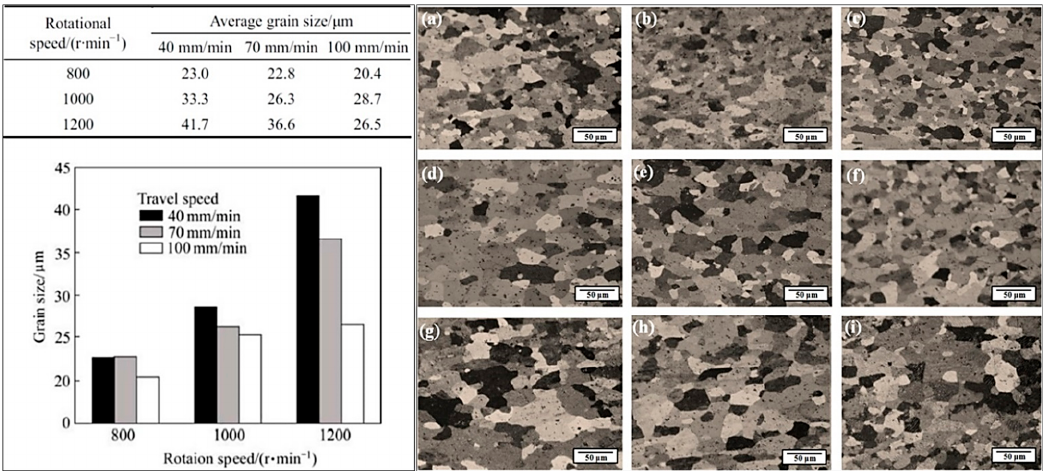
Figure 4. Optical microscope images and average grain size values of HAZ in FSW joint of AA3003- H18 at various rotation and travel speeds: ( a ) 800 r/min, 40 mm/min; ( b ) 800 r/min, 70 mm/min; ( c ) 800 r/min, 100 mm/min; ( d ) 1000 r/min, 40 mm/min; ( e ) 1000 r/min, 70 mm/min; ( f ) 1000 r/min, 100 mm/min; ( g ) 1200 r/min, 40 mm/min; ( h ) 1200 r/min, 70 mm/min; ( i ) 1200 r/min, 100 mm/min [38].